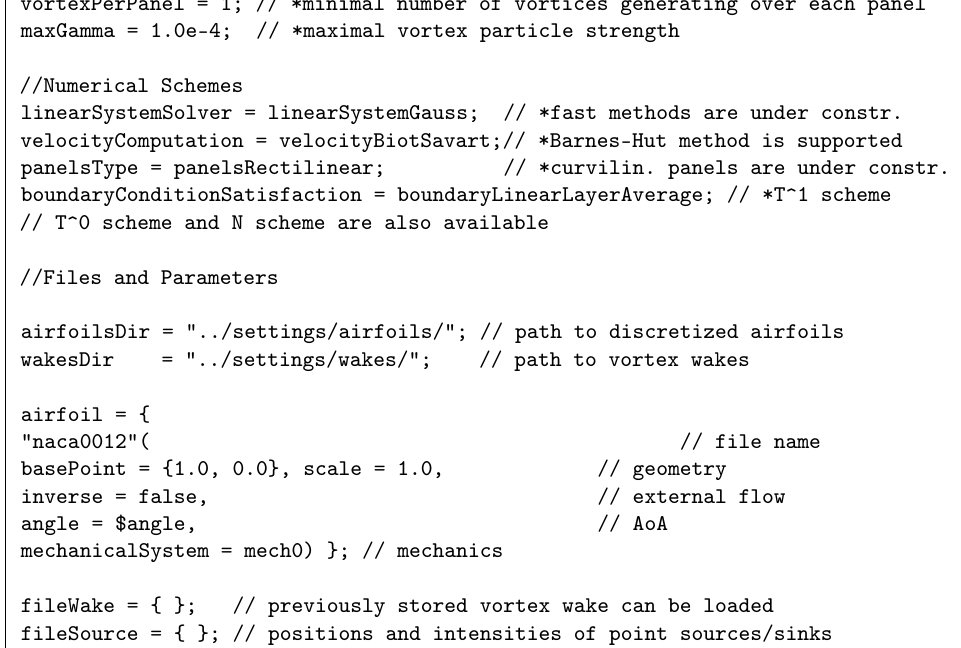
Figure 14. The typical structure of the passport